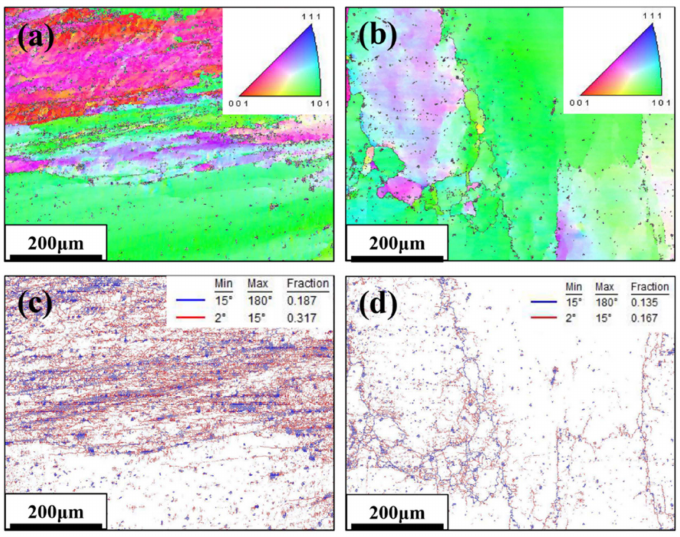
Figure 2. IPF results and boundary contrast (BC) images of hot rolled plates: ( a , c ) 25 mm; ( b , d ) 65